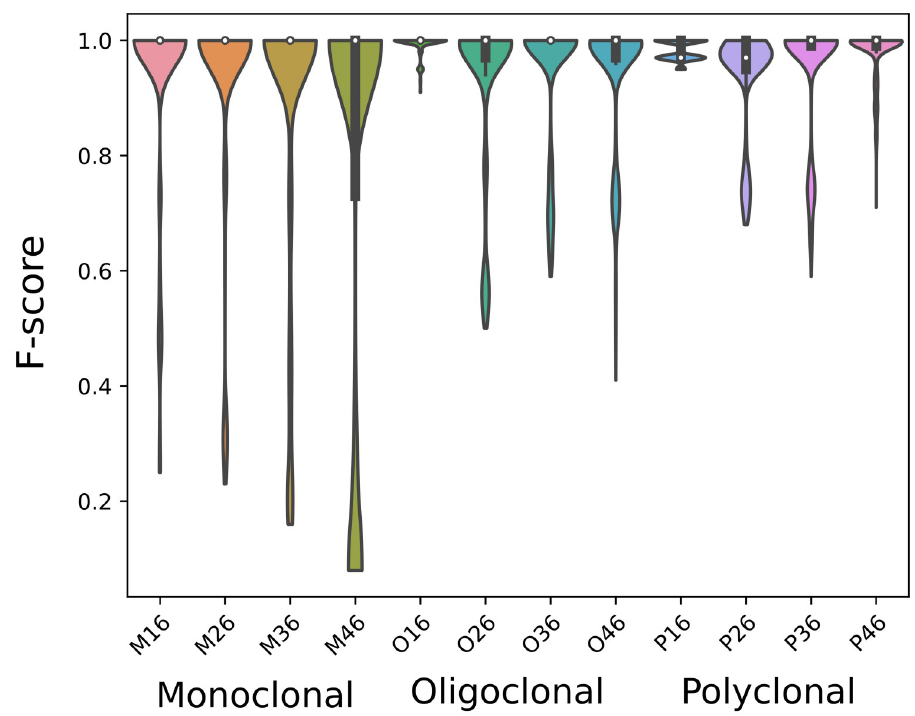
Fig 3. Performance of different parameter configurations. We computed the closeness F-score distribution for all simulated repertoire. Each distribution contains 4480 values, one for each parameter configuration. Samples are sorted by repertoire types and SHM rates.